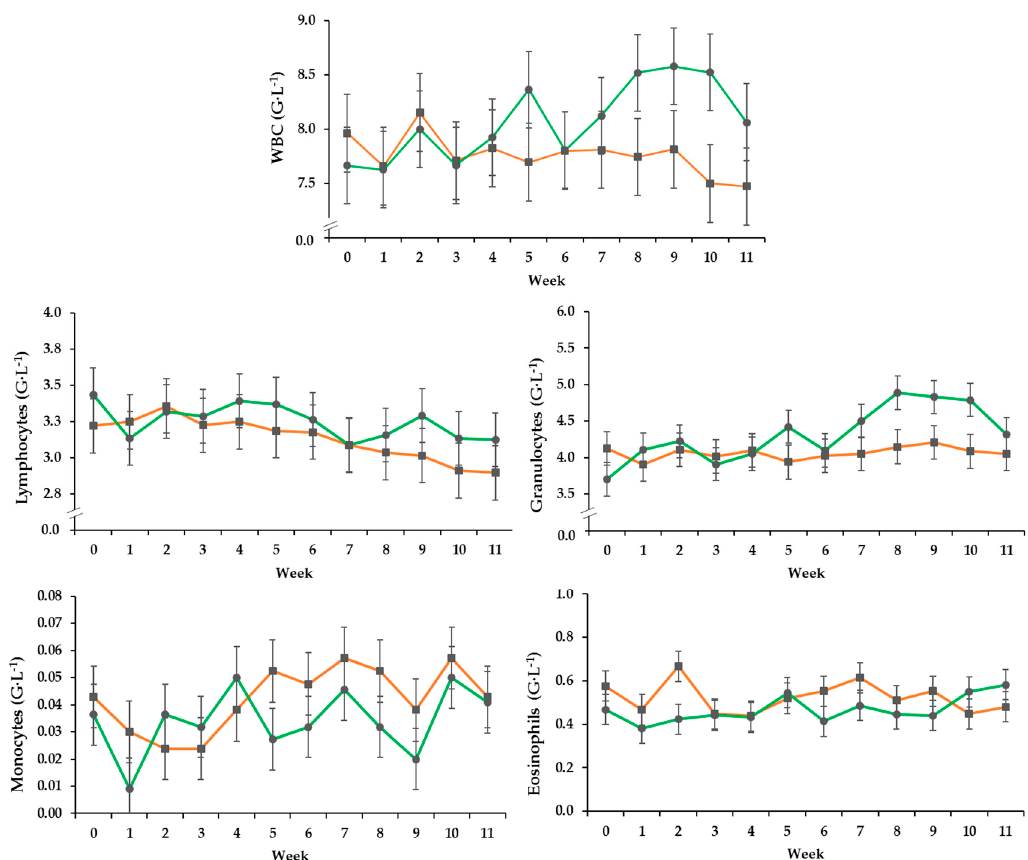
Figure 1. Effect of a ration change from an indoor based TMR to pasture on development of total white blood cell count, and numbers of granulocytes, eosinophils, lymphocytes and monocytes (G · L − 1 = 10 9 cells per Liter), all data points include standard error bars; • = pasture group (PG; n = 22, green); (cid:4) = confinement group (CG; n = 21, orange). The results of the statistical analyses are shown in the accompanying table. The CG stayed on a TMR-based diet during the entire trial, while the PG was slowly introduced to a pasture-based ration: weeks 0 and 1 = TMR, week 2 = TMR and 3 h pasture · day − 1 , weeks 3 and 4 = TMR and 12 h pasture · day − 1 , week 5 to 11 = pasture and 4.5 kg of DM concentrate · day − 1 . Table 3. Results of the statistical analyses.